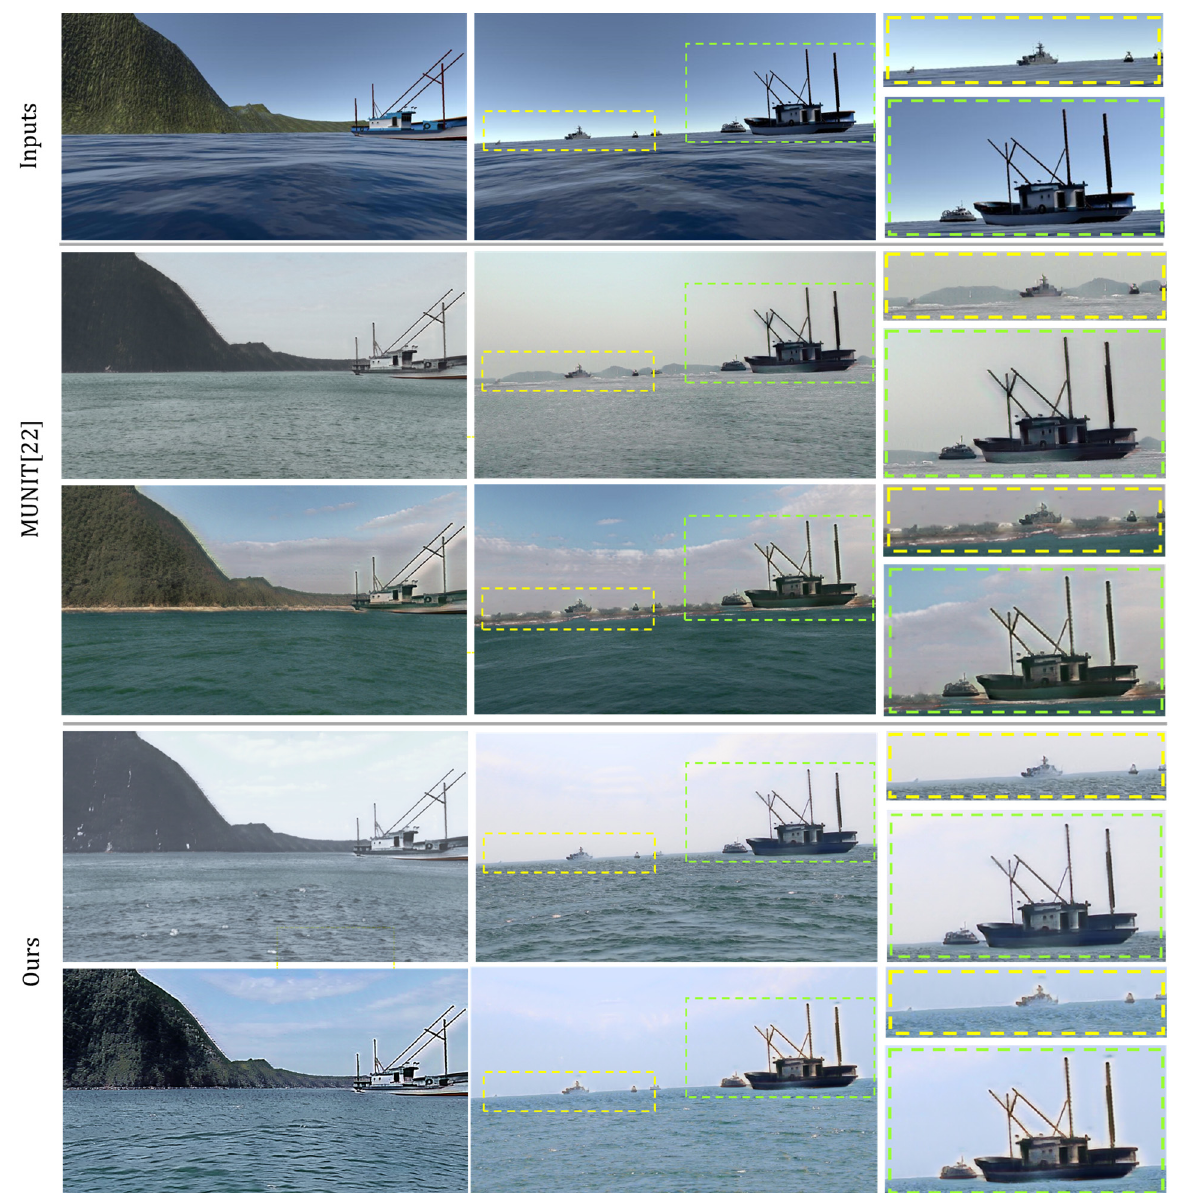
Figure 9. Horizon-targeted loss effect results; the first column shows that MUNIT [22] and our proposed method can generate realistic images which do not include the horizon line. However, the second and the third column show our proposed method maintain the shape of horizon line in a yellow box and vessel shape in a green box more clearly than MUNIT [22] in the case of horizon scene.